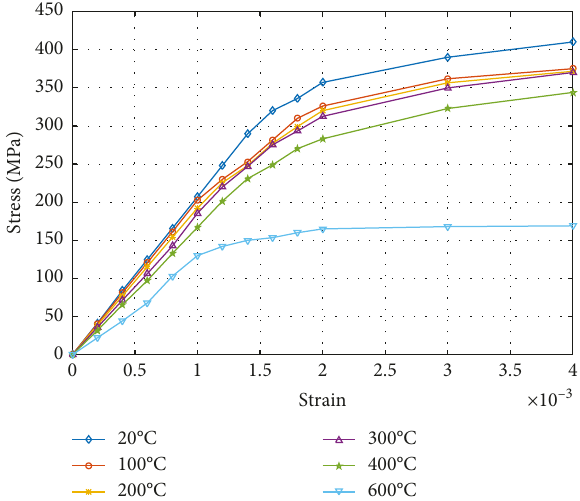
Figure 4: Stress-strain curves of Q355 steel pipe at different